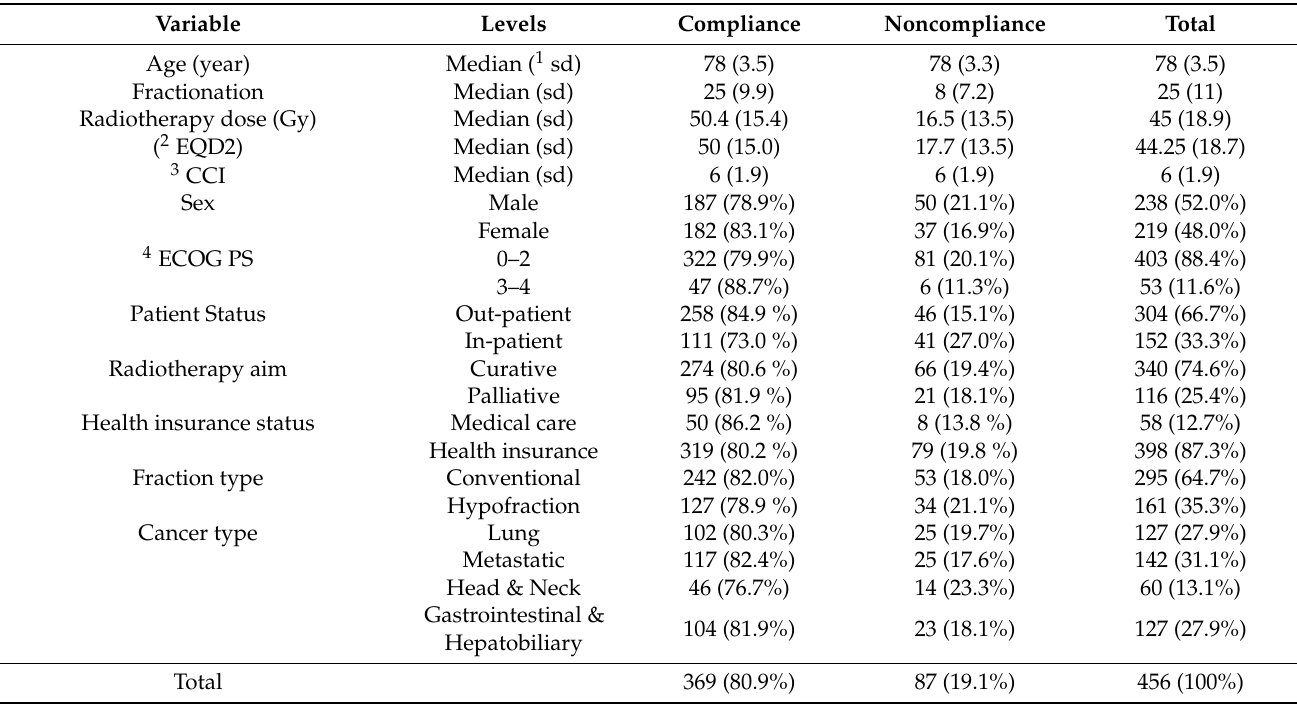
Table 1. General patient demographic and clinical